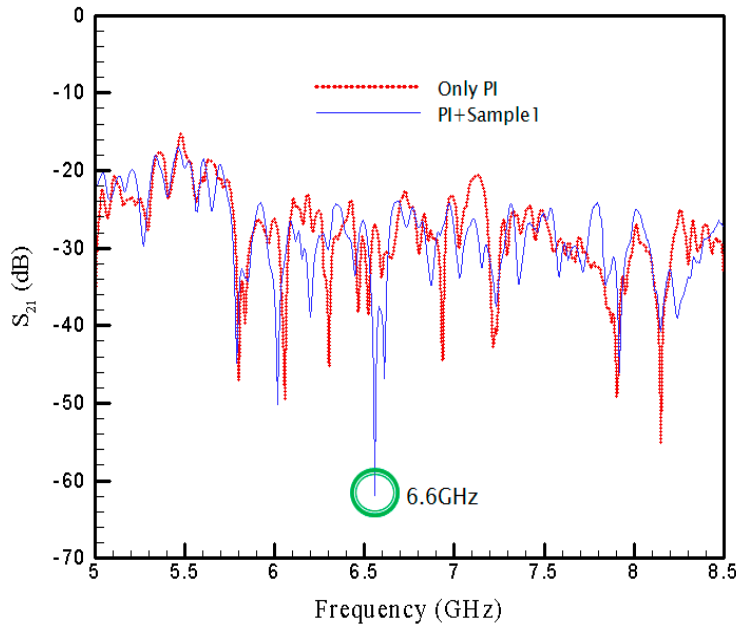
Figure 8. Transmission coefficient with SRR1.